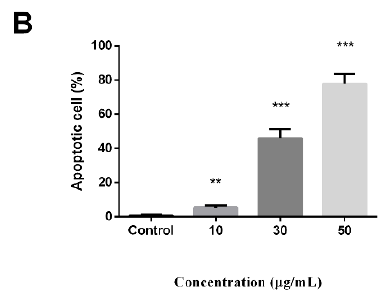
Figure 4. Effect of peperomin E on apoptosis of PC-3 cells by flow cytometry for Annexin-V-FITC and propidium iodide (PI) dual labeling. ( A ) Cells were treated with a vehicle ( a ) or peperomin E at 10 µg/mL ( b ), 30 µg/mL ( c ) or 50 µg/mL ( d ) for 72 h. The cell populations in the lower right represents early apoptotic cells, upper right represents late apoptotic cells. ( B ) The apoptotic rates of PC-3 cells induced by Pepromin E. Data are presented as means ± SD ( n = 3). * P < 0.05, ** P < 0.01, *** P < 0.001 versus Con